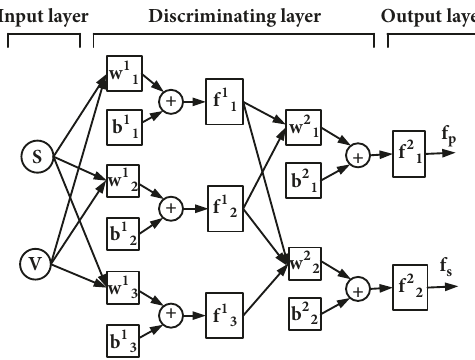
Figure 13: Diagram of perceptron neural network.